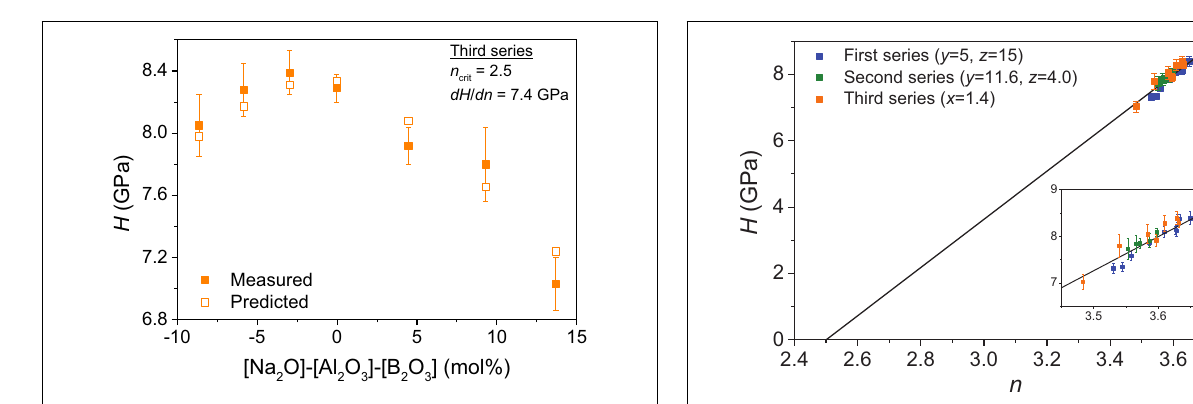
FIGURE 4 | MeasuredVickers hardness ( H ) at 0.49N for the three series of sodium boroaluminosilicate glasses [(100 − x − y − z ) SiO 2 − x Al 2 O 3 − y B 2 O 3 − z Na 2 O)] as a function of the calculated average number of room temperature ( T < T γ ) constraints n (Eq. 2) .The solid line represents Eq. 1 with dH / dn = 7.3GPa.The inset is an enlarged view of the H vs. n data.